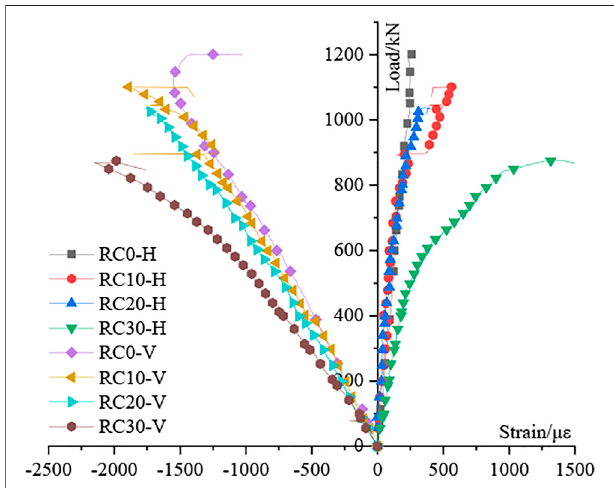
FIGURE 9 | Load-strain curve comparison of unreinforced